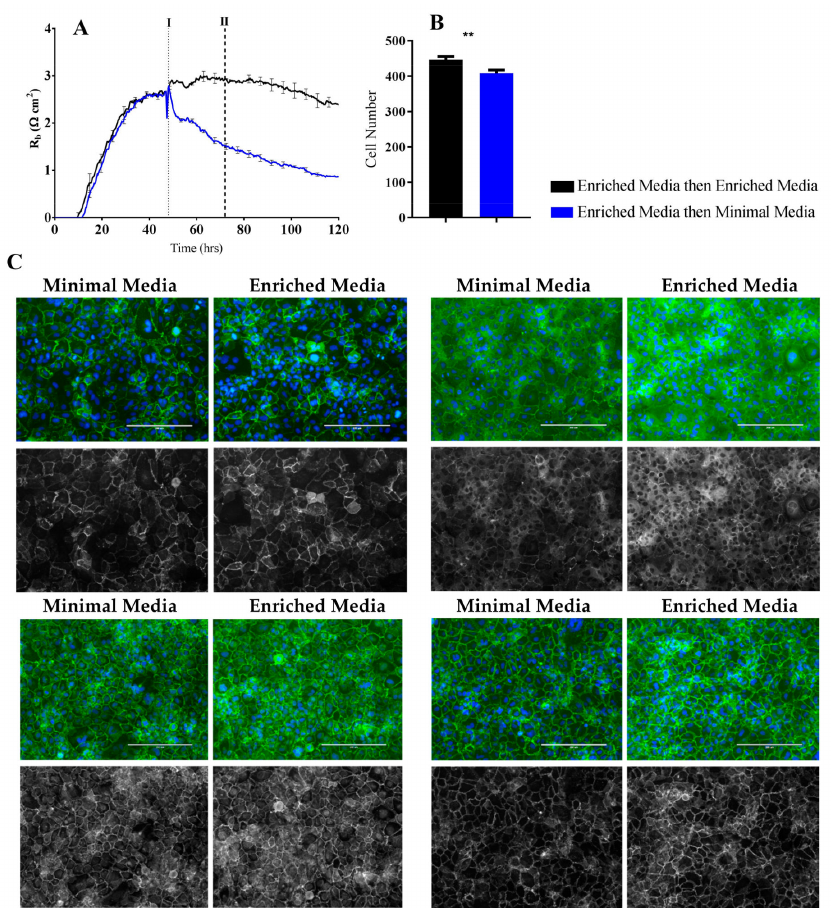
Figure 7. Immunocytochemistry of brain endothelial junctional space following growth in either Enriched Media or Minimal Media. Cells were seeded at time 0 h at 20,000 cells per 0.3 cm 2 . ( A ) ECIS resistance and R b measurements over 120 h. Cells were grown in either Enriched Media or Minimal Media from T = 0 h, with media changed at T = 48 h (I). Data shown is the mean ± S.D. (n = 3 wells) of 1 independent experiment representative of 3 experimental repeats; ( B ) Cell number count of Hoechst stained nuclei at time point II, obtained through Image J Software analysis. Data shown is the mean ± SEM (n = 18 wells) of 1 independent experiment representative of 3 experimental repeats; ( C ) The junctional space following growth in either Enriched Media or Minimal Media 72 h post seeding. The time point of fixation corresponds to the second vertical dotted line (II) shown on the ECIS traces. Representative GFP/DAPI and GFP monochrome images for the junctional proteins CD144, ZO-1, β -catenin and α -catenin are shown. Each panel shows cells grown in Minimal Media on the left and cells grown in Enriched Media on the right. The corresponding Alexa Fluor 488 (GFP) monochrome image is shown below each merged image. Green—junctional protein, blue—nuclei. Scale bar is 200 µ m. Immunocytochemistry data shows 1 representative image from 1 independent experiment, which is representative of 3 experimental repeats. Graphical representations of p values are * p ≤ 0.05, ** p ≤ 0.01, *** p ≤ 0.001, **** p ≤